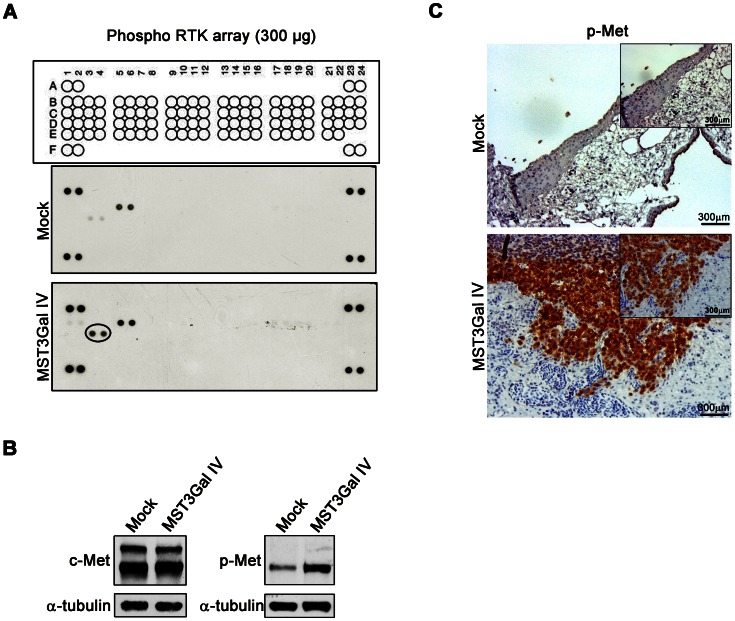
Tyrosine kinase receptors activation evaluation in gastric carcinoma cells; increased c-Met in MST3GAL IV cells.
A – phospho-RTK array of transfected Mock and MST3Gal IV cells. Total cell lysates were collected and 300 µg of total protein were incubated into a phospho-RTK membrane array. The array shows an increased activation of c-Met (HGFR) in MST3Gal IV cells. Activated receptors were matched according to the phospho-RTK array coordinates indicated in the material and methods section. c3, c4 correspond to c-Met ; B – Analysis of c-Met activation in MOCK and MST3Gal IV cells by Western blot; Cell lysates were analyzed by Western blot with antibodies directed against human c-Met and the phosphorylated tyrosine residues 1234/1235 of the kinase domain to confirm the activation of c-Met in MST3GAL IV cells. The results show an increase expression of phosphorylated c-Met (p-Met) in MST3Gal IV cell line with no differences in c-Met total protein levels in both cell lines. Anti-tubulin antibody was used to assess loading. C – Expression of phosphorylated c-Met was assessed in CAM tissues. The evaluation of c-Met activation in CAM tumors show that MST3Gal IV/SLex expressing cells present positive staining for phospho c-Met and that the resulting invading cells are also positive for the phosphorylated form of this receptor.